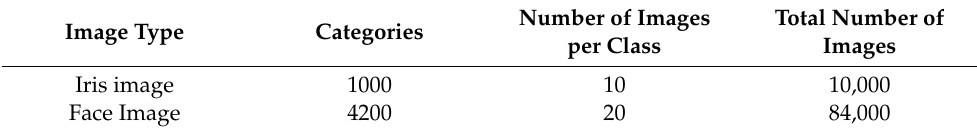
Table 2. Dataset specifications of separation in the training phase.